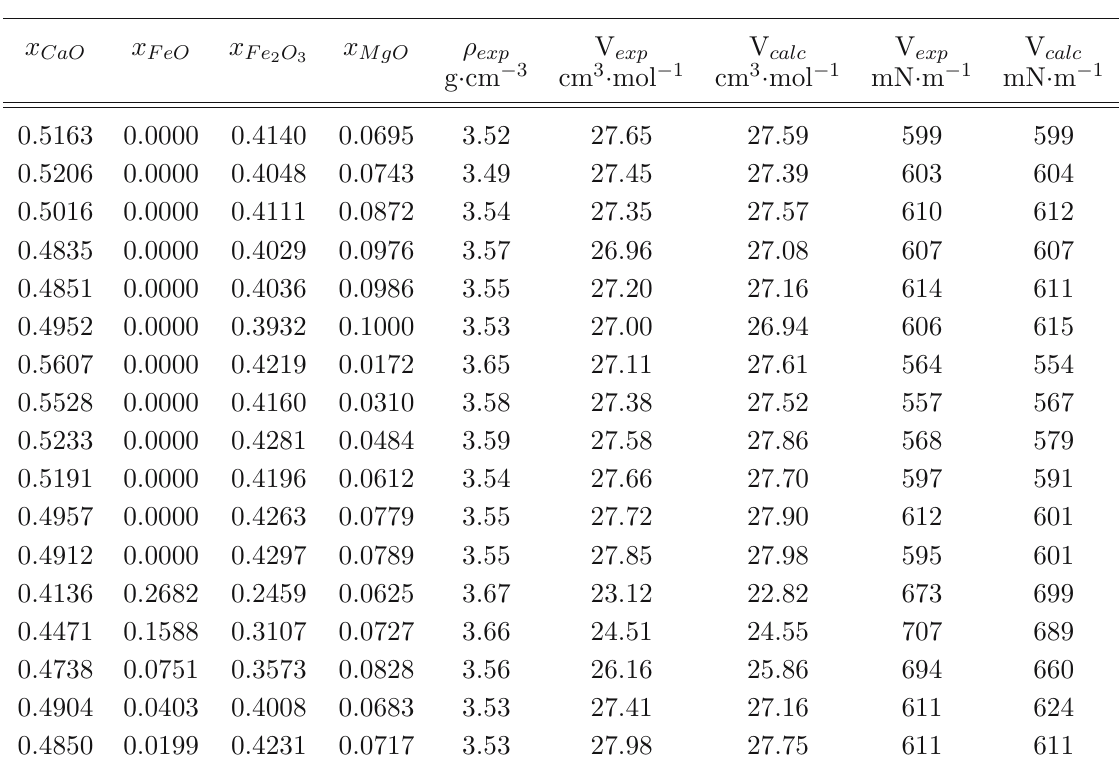
Table 1 Experimentally determined values of the density, molar volume and surface tension of the investigated melts of the system CaO-FeO-Fe 2 O 3 -MgO at the temperature of 1623 K.